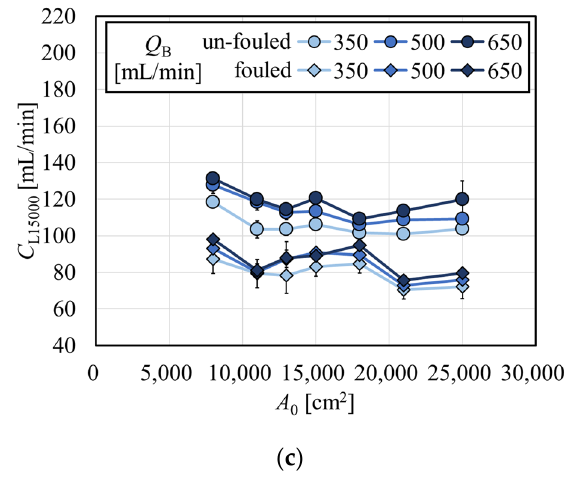
Figure 9. Clearances normalized to the effective surface area of 15,000 cm 2 ( C L15000 ) as a function of A 0 for ( a ) creatinine, ( b ) vitamin B 12 , and ( c ) inulin.